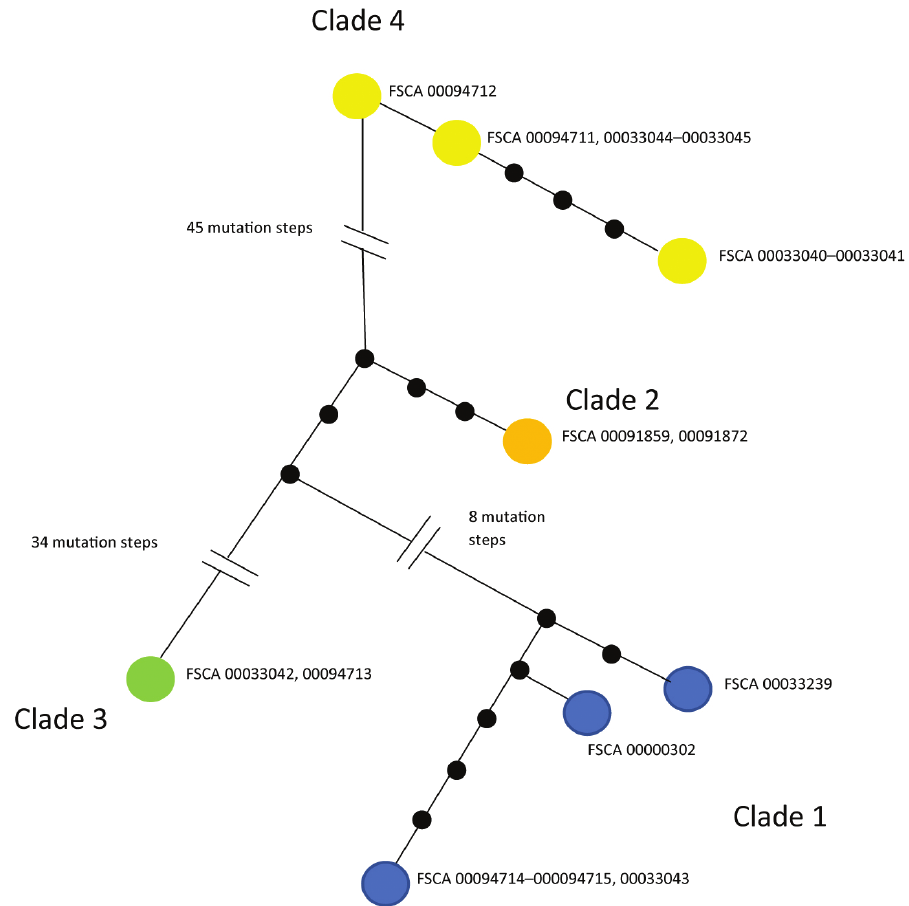
Figure 3. TCS COI haplotype network for the four clades of T. utahensis by fixing connection limits at 50 steps. Each haplotype is represented by a colored circle. Lines represent one mutational step between haplotypes, and dark circles represent unsampled haplotypes inferred from the data. Interrupted lines were used when haplotypes were separated by a long branch of more than 7 mutation